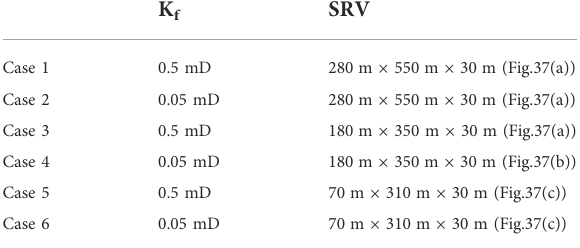
TABLE 2 Parameters used for the simulations.